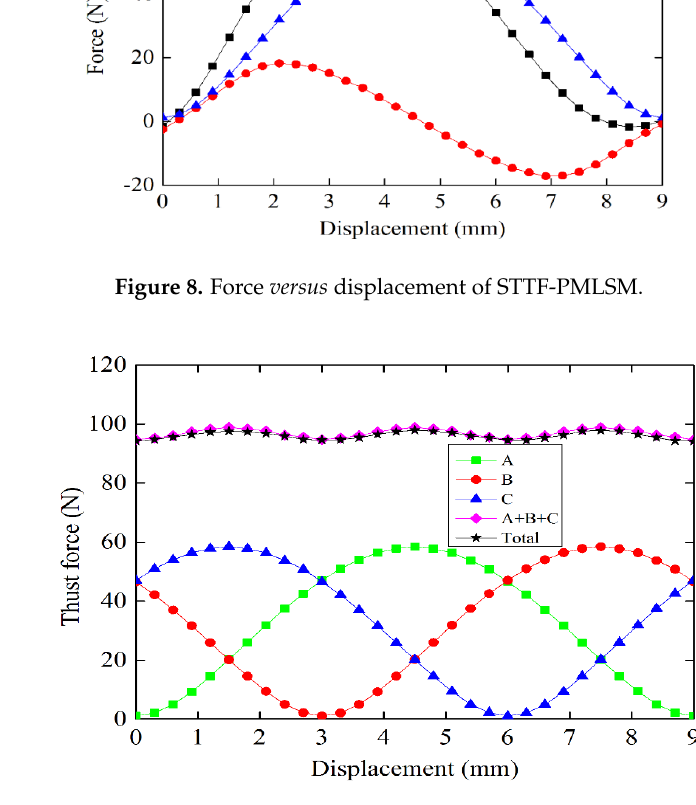
Figure 9. Thrust Force versus displacement of STTF ‐ PMLSM. Table 2. Thrust Force of STTF ‐ PMLSM.